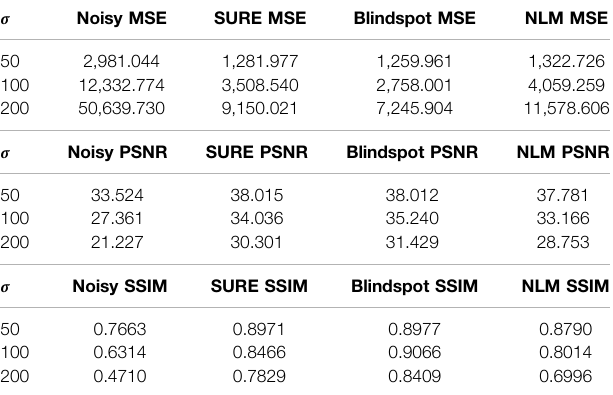
TABLE 2 | Test results for the Brainweb dataset.